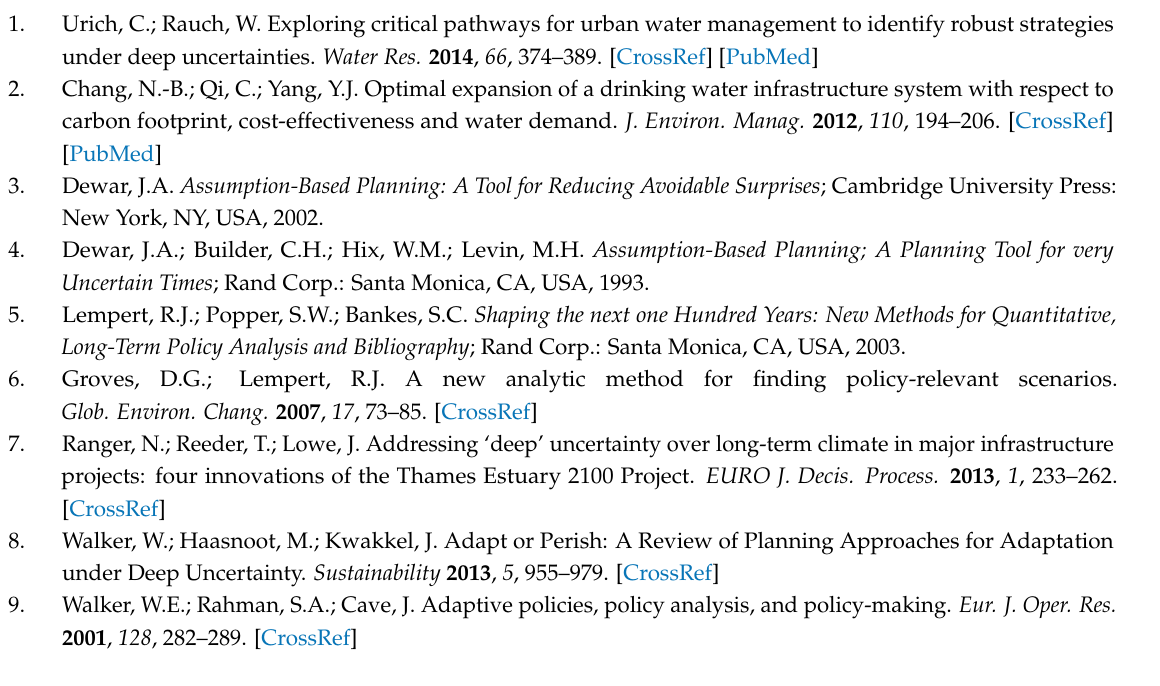
S1: Adaptation Tipping Points of Adaptation Actions. Please refer to Table 1 in the main paper for the key of action portfolios, Figure S2: Adaptation Tipping Points for the Waas Case, Table S1: Climate Scenarios, Kent Ridge Case Study, Table S2: Land Use Scenarios, Kent Ridge Case Study, Table S3: Results BTT sequencing approach using ROA as selection criterion, Kent Ridge Catchment., Table S4: Results BU sequencing approach using ROA as selection criterion, Kent Ridge Catchment., Table S5: Results BTT sequencing approach using NPV as selection criterion, Kent Ridge Catchment, Table S6: Results BTT sequencing approach using NPV as selection criterion, Table S8: Results BU sequencing approach using ROA as selection criterion, Waas Case, Table S9: Results BTT sequencing approach using NPV as selection criterion, Waas Case, Table S10: Results BU sequencing approach using NPV as selection criterion, Waas